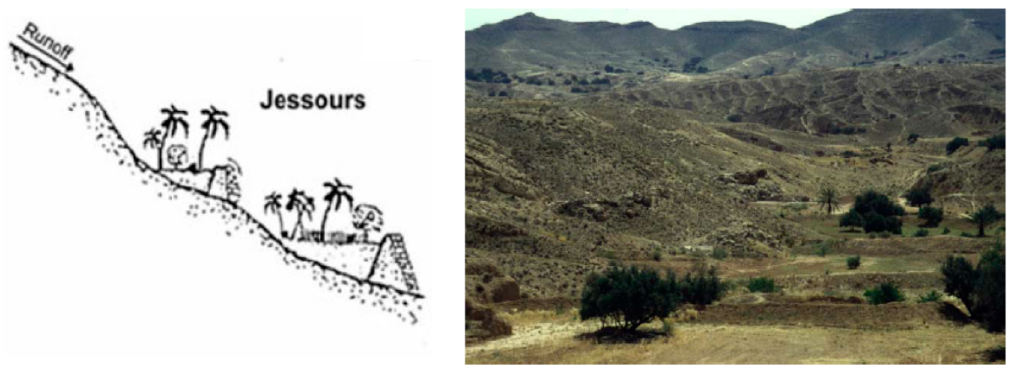
Figure 4. Jessours in southern Tunisia for growing tree crops (adapted from [39]; photo of A. Bahri).